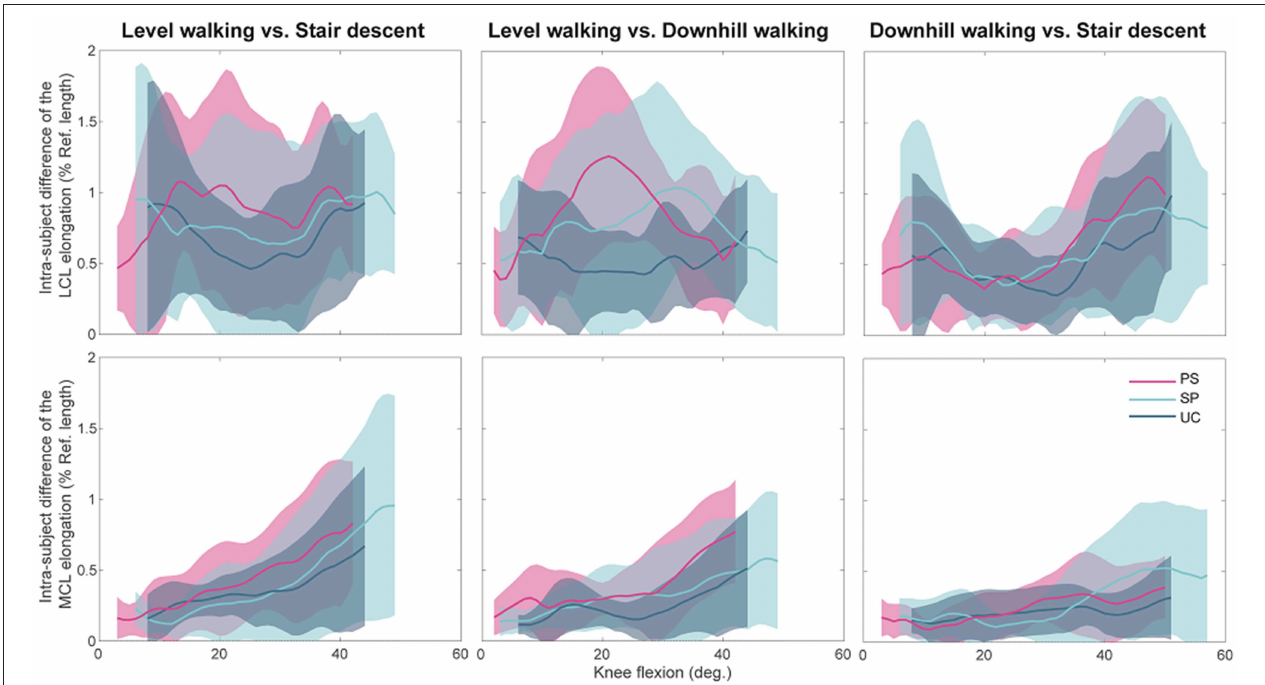
FIGURE 7 | The intra-subject differences in ligament elongations between activities for the three groups of implant designs plotted against the knee flexion angle. Average patterns (solid lines) and standard deviations (shadings) were calculated only over the flexion ranges achieved by all the subjects within an implant design group during all the five included trials.